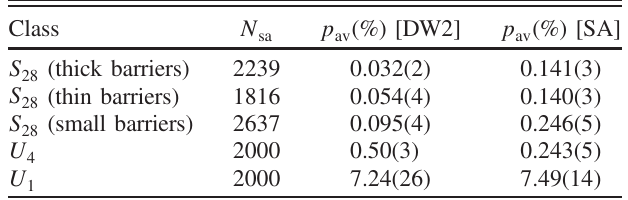
TABLE I. Simulated annealing parameters used for the differ- ent instance classes. For each type of disorder class J Monte Carlo sweeps are performed on an annealing schedule from β to β i f